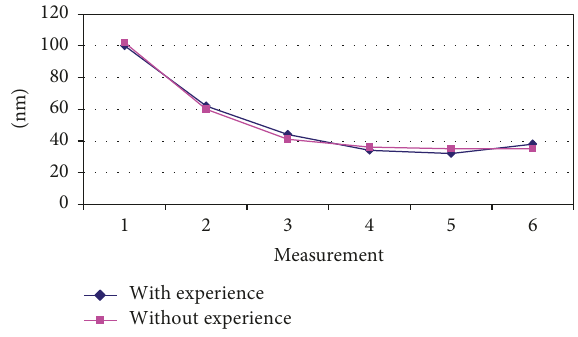
Figure 3: Dynamics of sensibility threshold for interocclusal thick- ness according to experience with complete